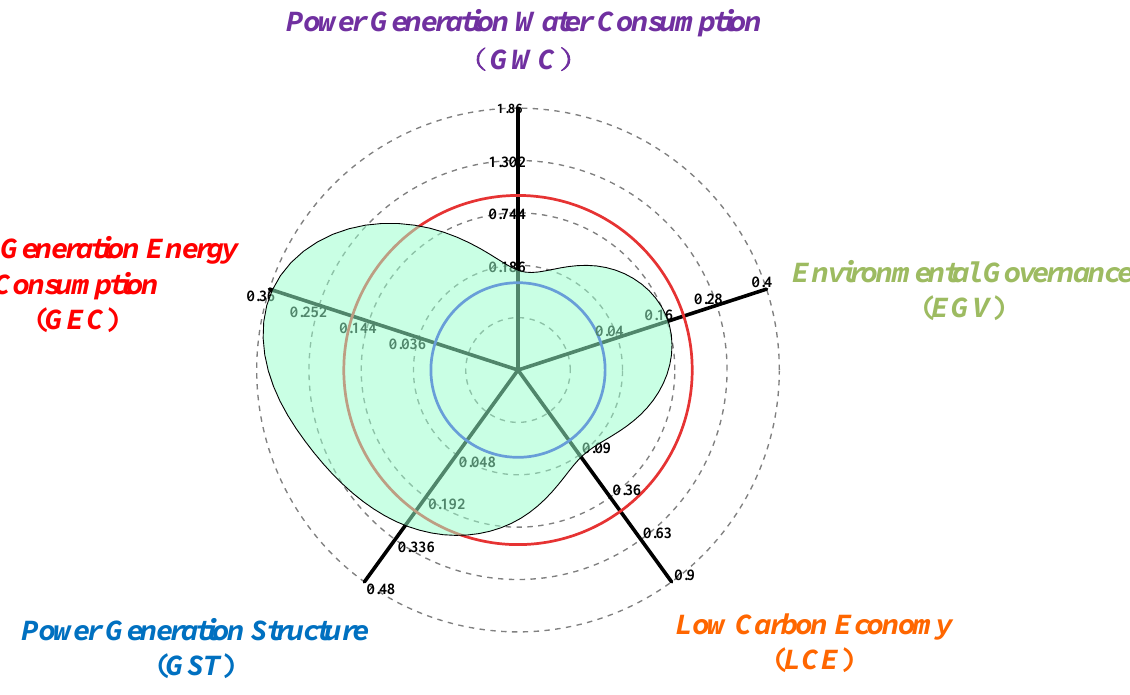
Figure 4. Evaluation results of comprehensive indicators of carbon emissions from coal power samples.